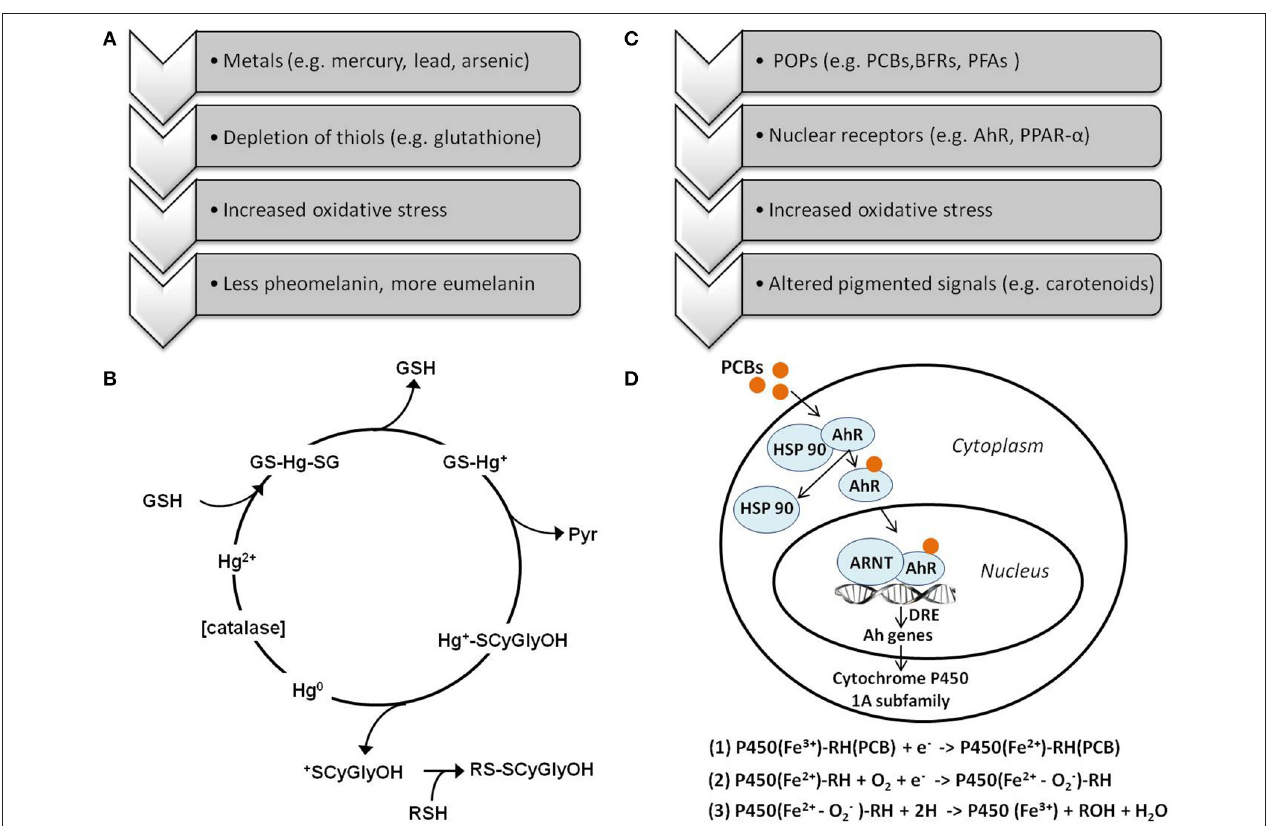
FIGURE 2 | (A) Simplistic diagram of the hypothetical links among heavy metals, oxidative stress, and coloration via the glutathione pathway; (B) Schema of the catalytic cycle for the depletion of the cellular glutathione pool by mercury, proposed on the basis of mass spectrometric behavior, and biochemical evidence (reprinted from ( Rubino et al., 2006) with permission from Elsevier); GSH, glutathione; GS-Hg + , mono-S-glutathionyl-mercury(II); Hg, mercury; CSCyGlyOH, oxidized cysteinyl-glycine; Hg + -SCyGlyOH, mercury(II)-cysteinyl-glycine conjugate; Pyr, pyroglutamic acid; RSH, thiols; (C) Simplistic diagram of the hypothetical links among persistent organic pollutants (POPs), oxidative stress, and coloration. Different classes of POPs can generate oxidative stress via binding with specific cellular receptors, including the aryl hydrocarbon receptor (AhR), and proliferator-activated receptor-alpha (PPAR- α ); (D) Schema of the effects of dioxin-like pollutants (e.g., co-planar PCBs, PBDEs) via induction of the cytochrome P450 pathway (adapted from Regoli and Giuliani, 2014) which induces uncoupling of the catalytic cycle of the cytochrome P450 1A subfamily allowing the heme iron within the active site of this enzyme complex to undergo cycles of oxidation and reduction, and act as a Fenton catalyst generating free radicals—AhR, aryl hydrocarbon receptor; Ah, aryl hydrocarbon genes (e.g., CYP1A , CYP1B ); HSP 90, heat shock protein 90; ARNT, aryl hydrocarbon receptor nuclear translocator; DRE, dioxin responsive element. Different classes of pollutants can act on the same cellular targets altering the